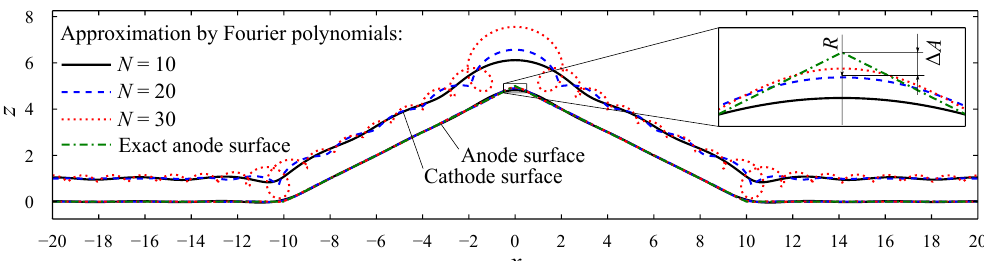
Figure 7. Example of cathode shape design for anodes with limited smoothness (spatial dimensions are normalized to the width of the standard equilibrium front gap). The 2D anode surface defined by the graph of the function defined by Equation (25) with A = 5 and L = 40 (thin dash-dotted line) is approximated by Fourier polynomials (Equation (26)) with N = 10, 20, and 30, which are illustrated by the solid, dashed, and dotted lines, respectively; the same line types are used to illustrate the corresponding cathodes obtained from Equations (28) and (29). The inset shows details of the exact anode and its approximations around x = 0 and z = 5 with R exemplarily denoting the radius of the curvature of the approximated anode ( N = 20) at x = 0 . The quantity ∆ A is the difference between the height of the approximated anode surface and that of the exact anode